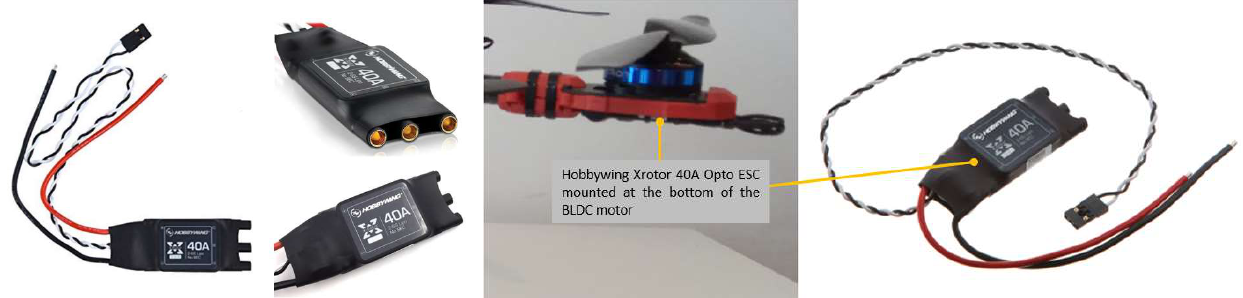
Figure 11. Hobbywing XRotor 40A Opto ESC.